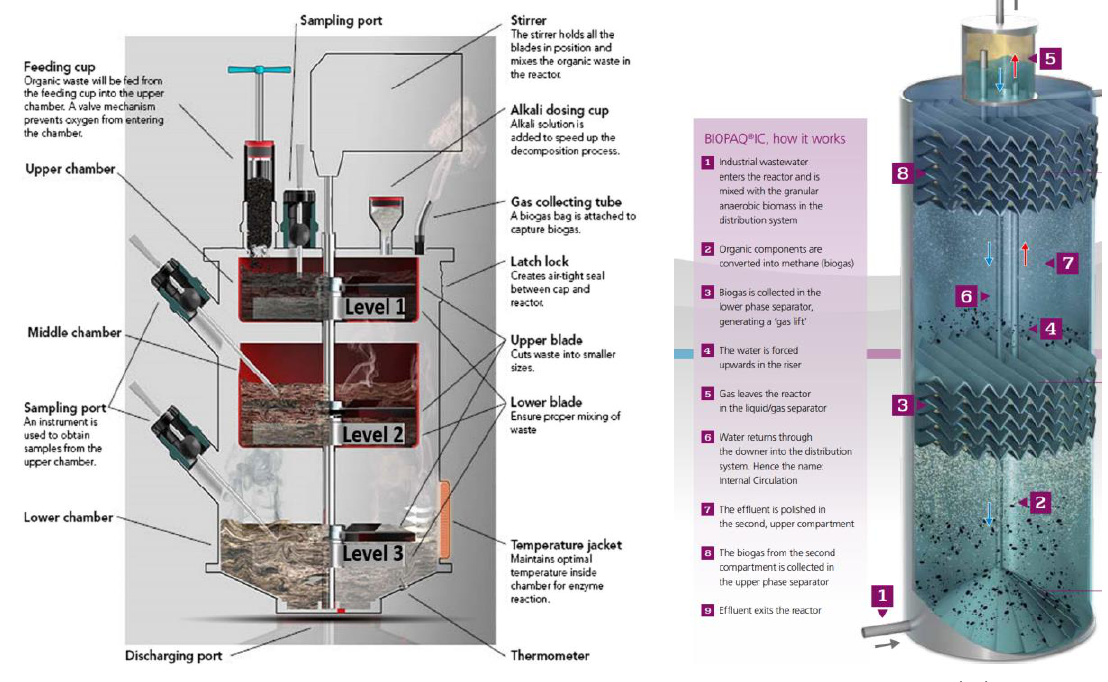
Figure 4. Example of two novel anaerobic reactor types—reproduced with permission from the original authors [7,161].